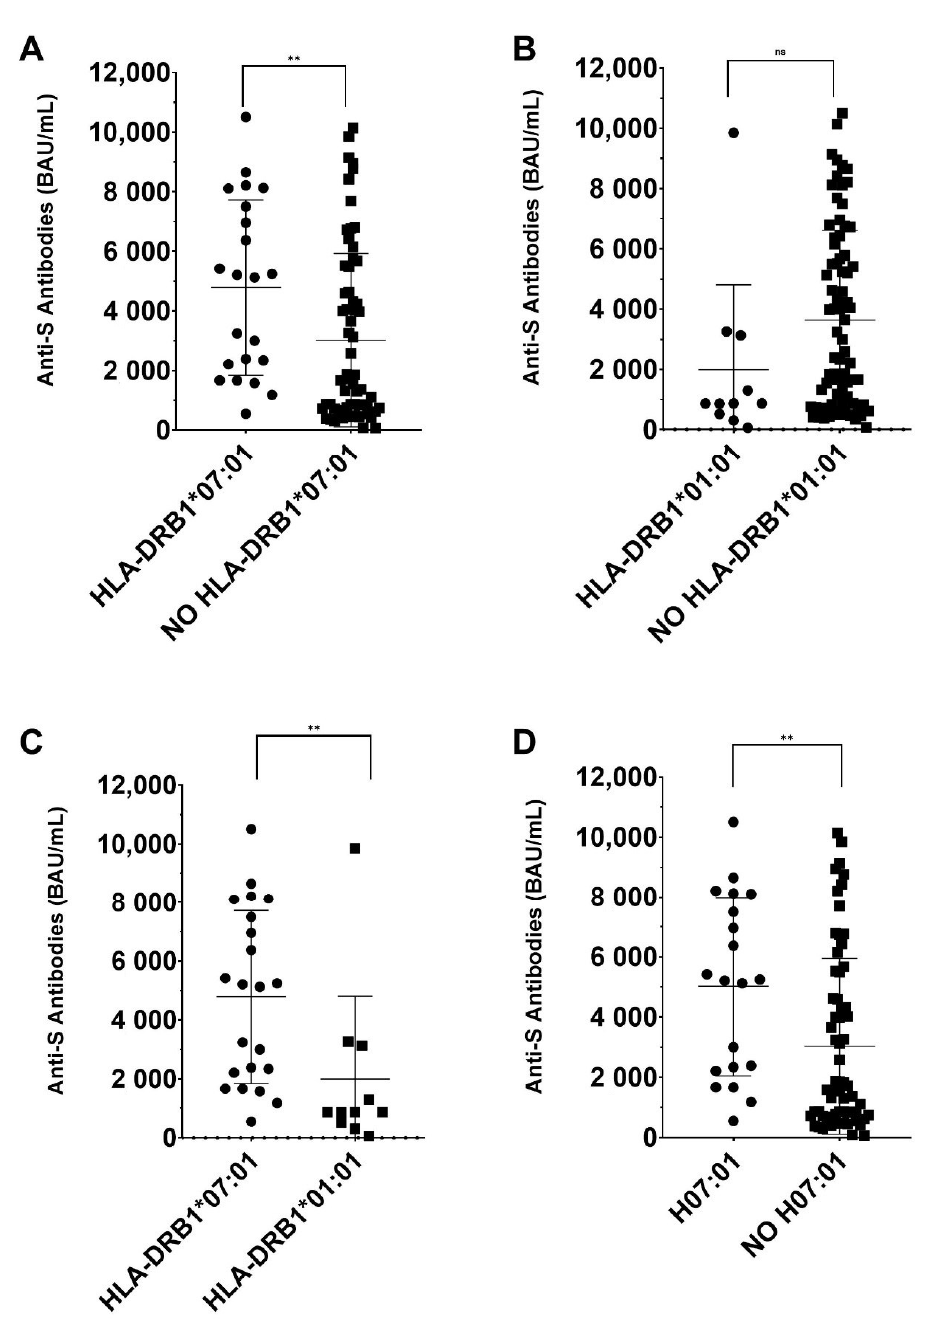
of HLA-DRB1*07:01 and the haplotype HLA-DRB1*07:01~DQA1*02:01~DQB1*02:02, with a higher level of anti-S antibodies (Figure 1). HLA-DRB1*01:01 does not influence the anti-S antibody production, but the subjects with HLA-DRB1*01:01 have lower anti-S antibody titers than volunteers with HLA-DRB1*07:01 (Figure 1).